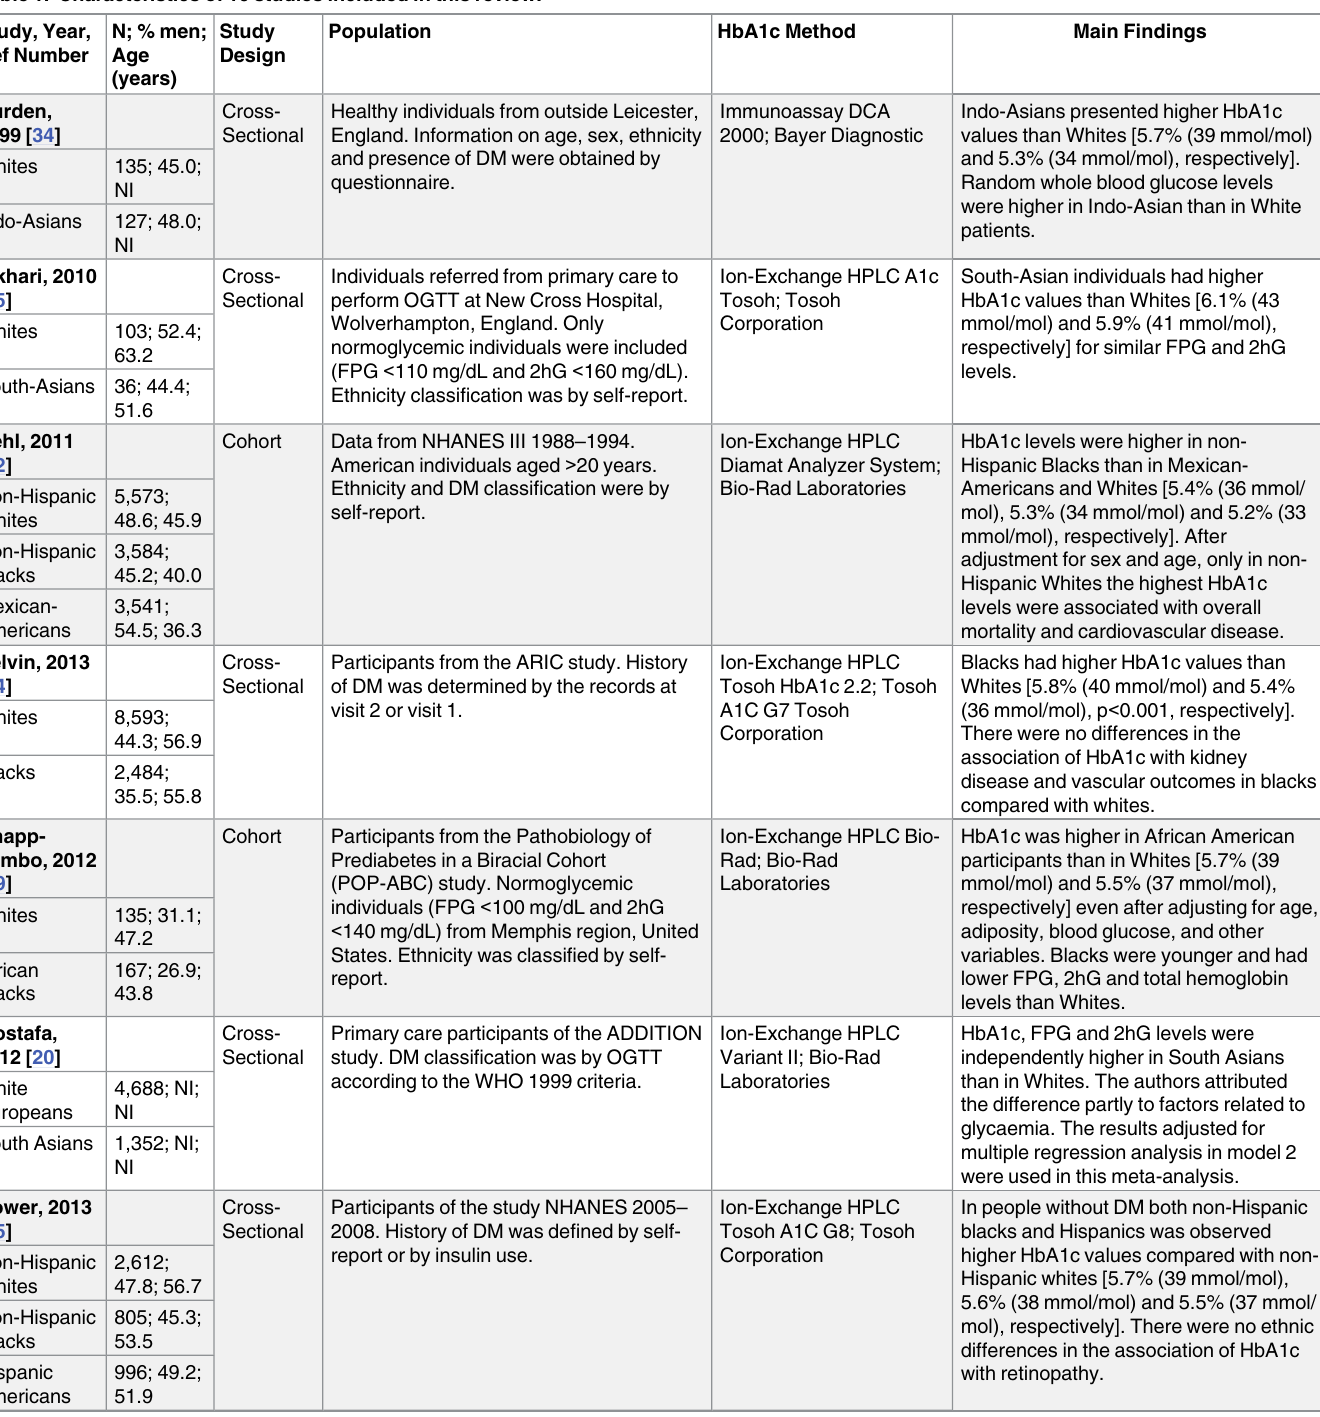
Table 1. Characteristics of 10 studies included in this